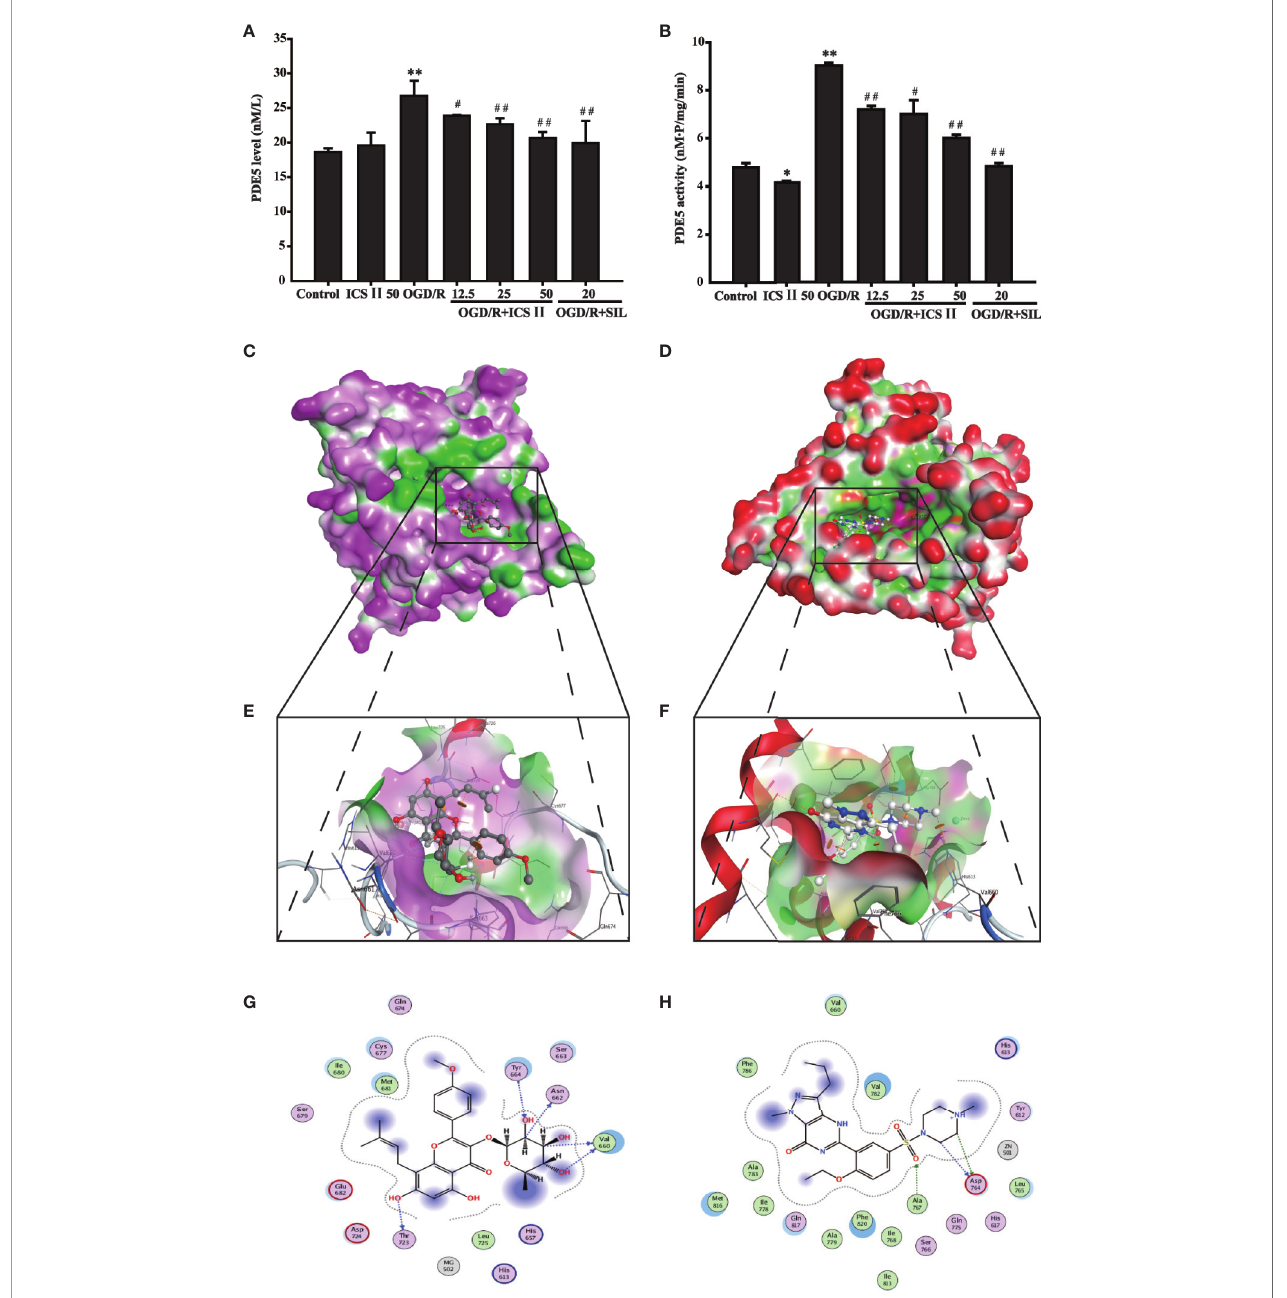
FIGURE 5 | ICS II binds and inhibits PDE5. (A) PDE5 protein expression was detected by ELISA kit. (B) PDE5 activity was detected by PDE5 activity kit. (C) Visual result of binding surface between ICS II and PDE5. (D) Visual result of binding sites between ICS II and PDE5. (E) . Visual result of binding surface between SIL and PDE5. (F) Visual result of binding sites between SIL and PDE5. (G) 2D interaction sides between ICS II and PDE5. (H) 2D interaction sides between SIL and PDE5. Data are presented as means ± SD (n = 3). * P < 0.05, ** P < 0.01 versus control group; # P < 0.05, ## P < 0.01 versus OGD/R